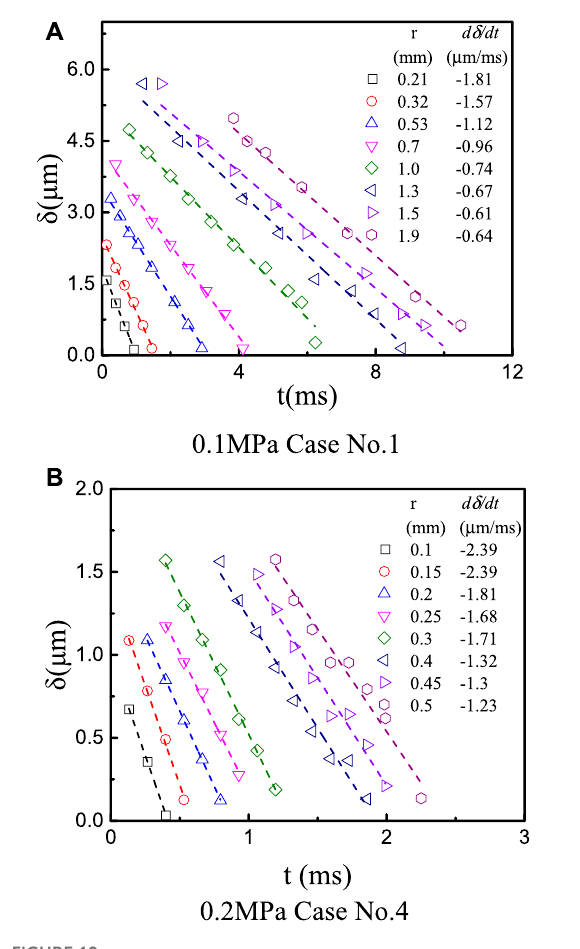
FIGURE 19 Pro fi le of microlayer thickness depletion in cases No. 1 and